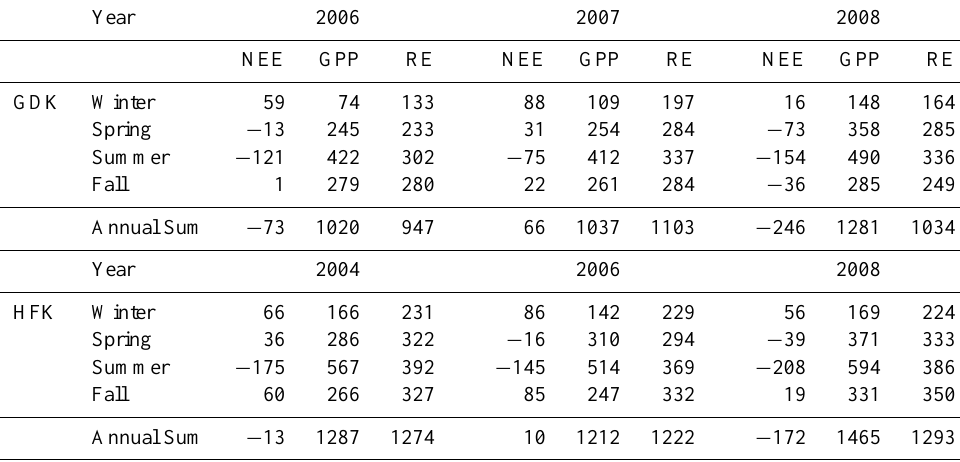
Table 1. Seasonal and annual budgets of Net Ecosystem CO 2 Exchange (NEE), Gross Primary Production (GPP), and Ecosystem Respira- tion (RE) for the GDK and HFK sites.